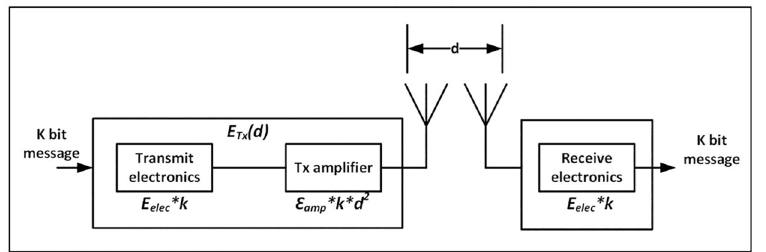
Fig 10. The Heinzelman first order radio